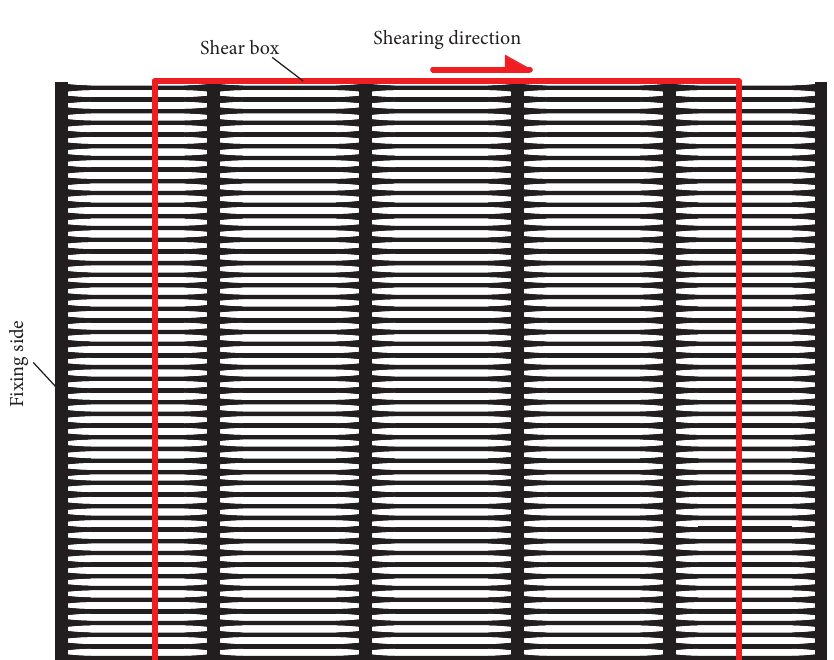
Figure 4: Geogrid with 100% cross